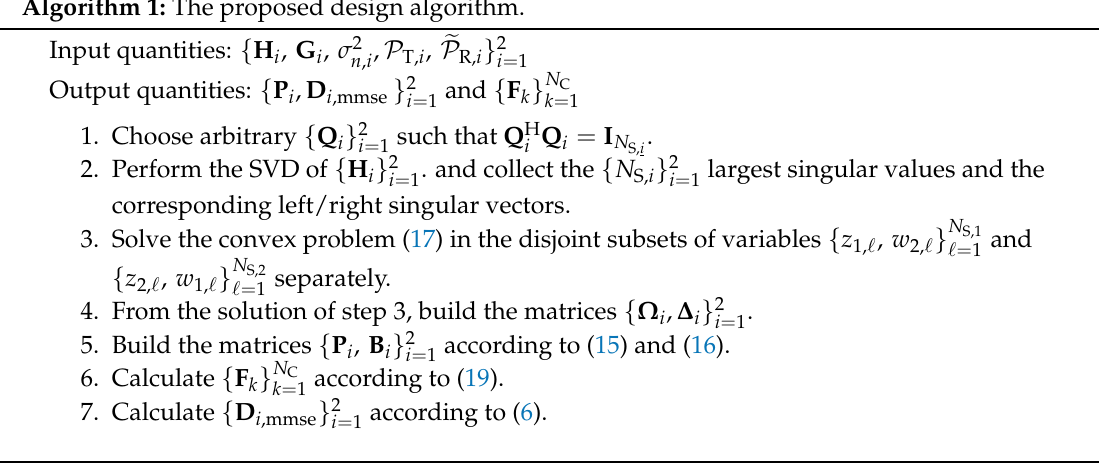
Algorithm 1: The proposed design